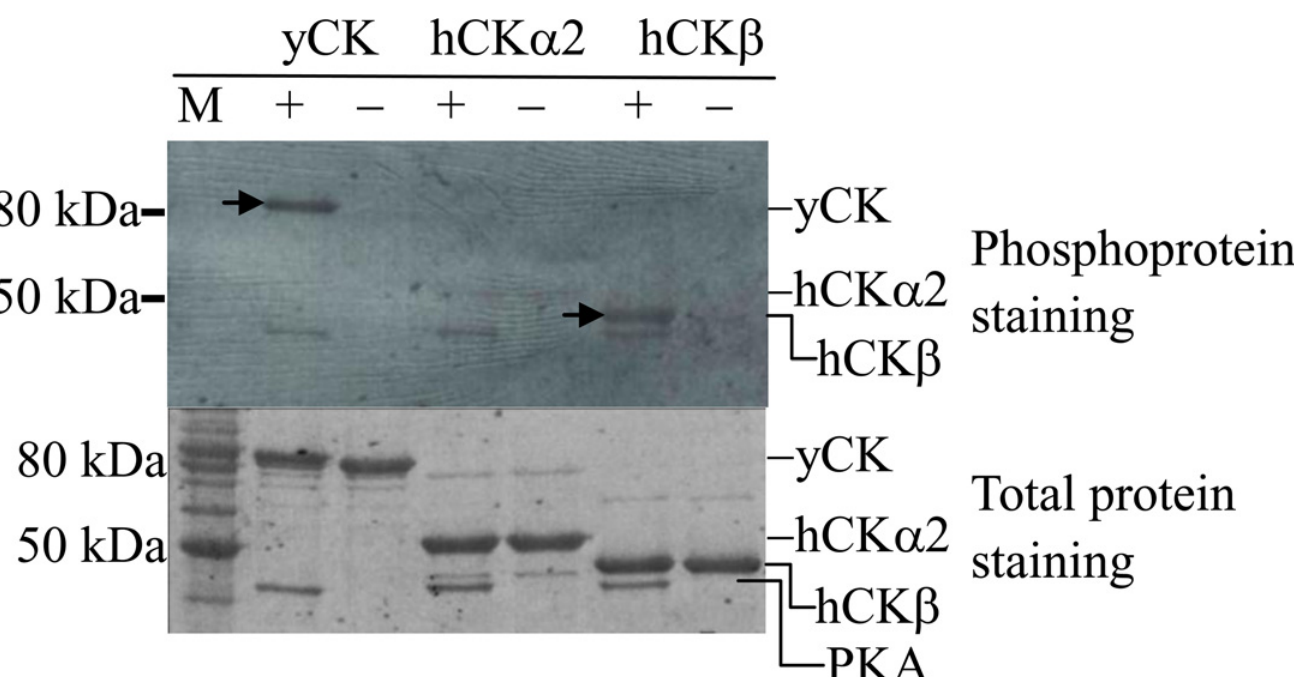
Fig 1. Protein kinase A phosphorylation of recombinantly produced and purified yeast (yCK) and human (hCK) choline kinases. yCK, hCK α 2, and hCK β were treated (+) with 80 U of PKA catalytic subunit. Unphosphorylated samples are indicated by “ − ” . Arrows indicate positive phosphoprotein staining for yCK and hCK β . M: BenchMark ™ Protein Ladder. Ten micrograms of the phosphorylated proteins were analyzed by 10% SDS-PAGE. Phosphorylated and total proteins were stained with Pro-Q Diamond phosphoprotein stain and SYPRO 1 Ruby stain, respectively.